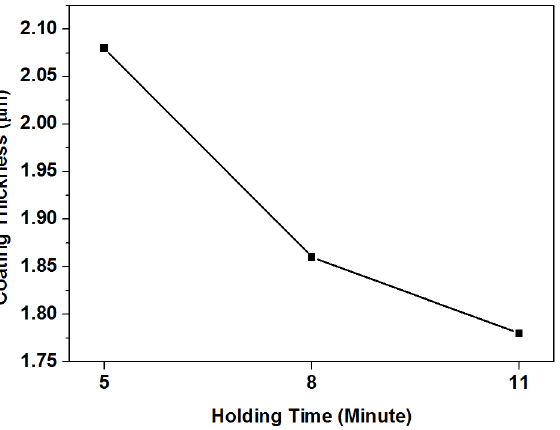
Figure 4. Effect of ultrasonic treatment on TiN coating thickness at 16 kHz for different exposure times.